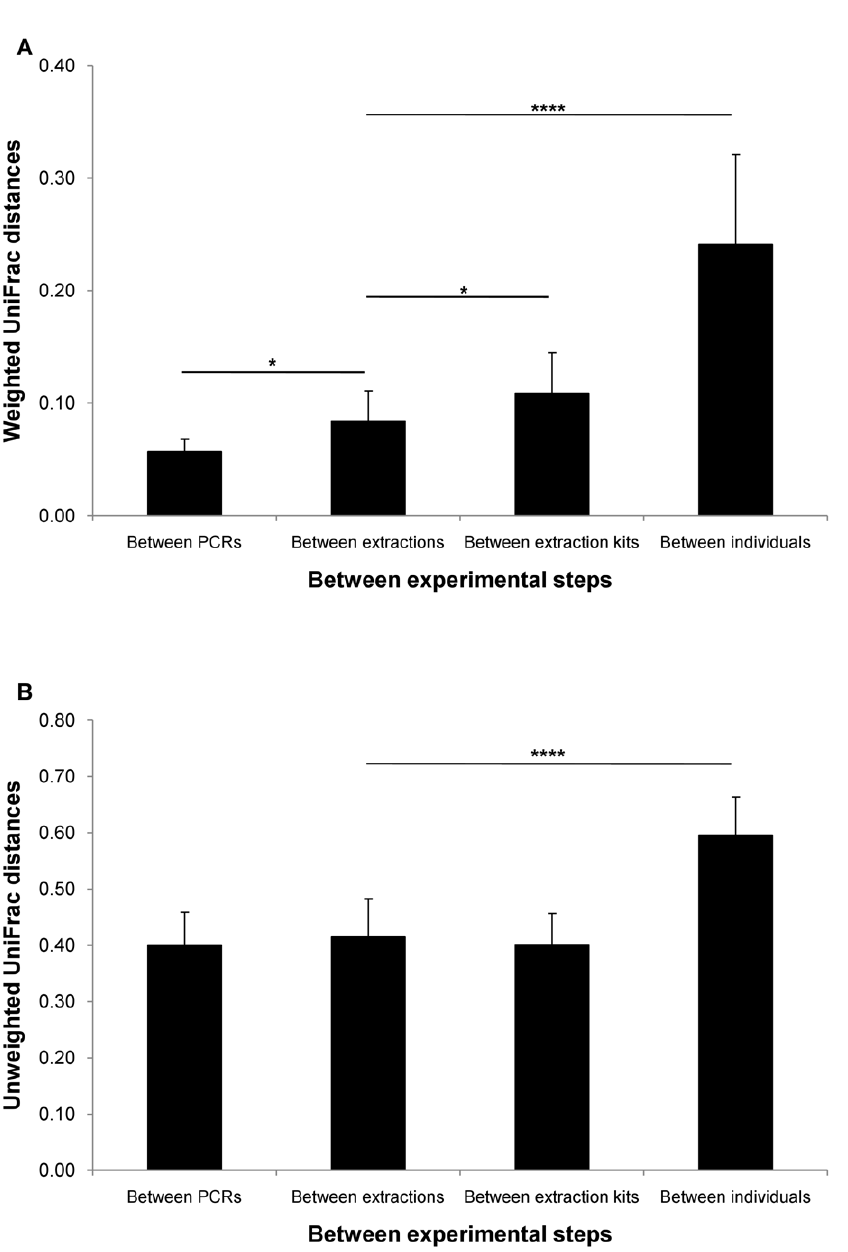
Figure 5. Effect of different experimental steps measured by UniFrac distances. (A) Weighted and (B) unweighted UniFrac distances. ‘Between extractions’ was used as a base measurement for comparison with other distances. Between PCRs: distances between PCRs using the same DNAs (n=8). Between extractions: distances between extractions of DNAs from two biopsy specimens from the same anatomic region or the same stool specimens by the Stool kit (n=18). Between extraction kits: distances between extractions of DNAs from two biopsy specimens from the same anatomic region by the Stool kit and the Mini kit (n=12). Between individuals: distances between 2 of 9 individuals from biopsies from transverse colon. Mean 6 SD, * p , 0.05, ****: p , 0.0001